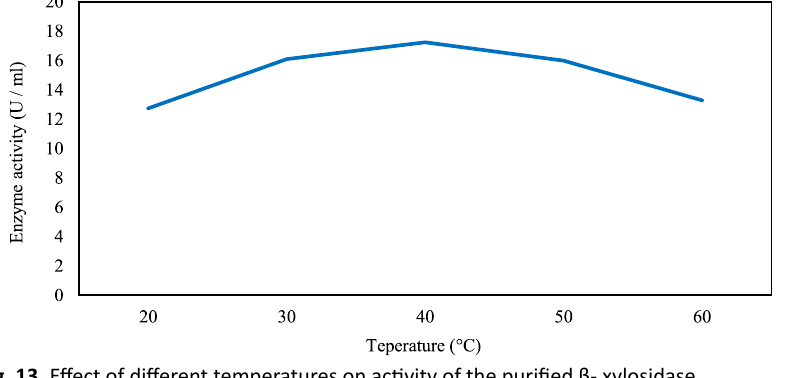
Fig. 13. Effect of different temperatures on activity of the purified β-